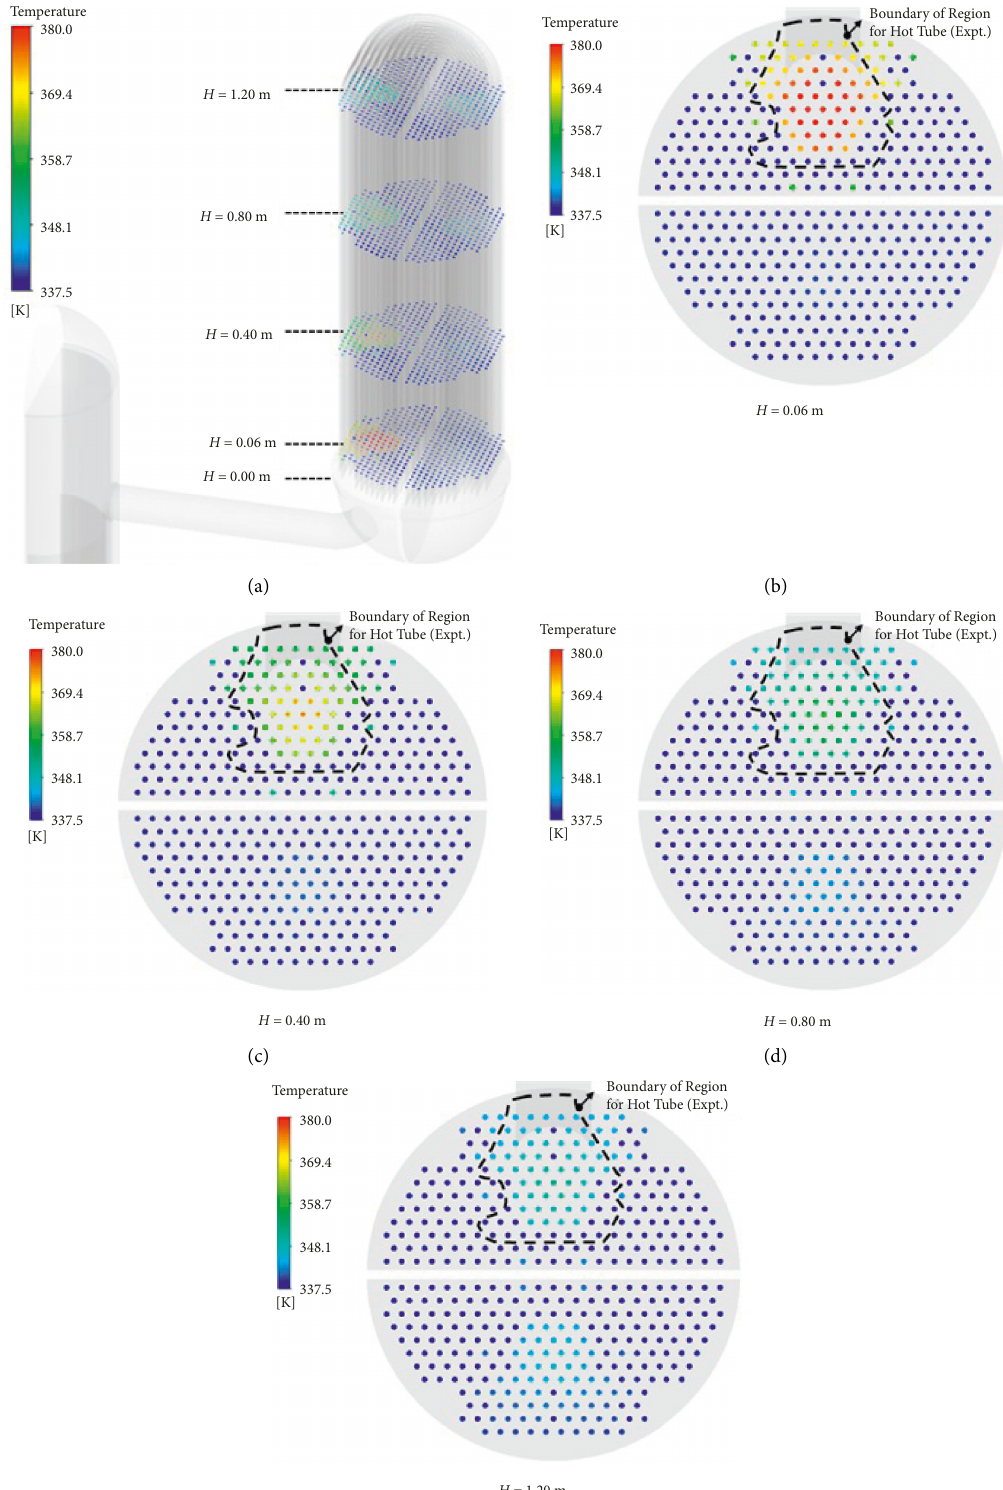
Figure 7: Temperature distribution on vertical plane (model 1). (a) Isometric view, (b) H � 0.06 m , (c) H � 0.40 m , (d) H � 0.80 m and (e) H � 1.20 m